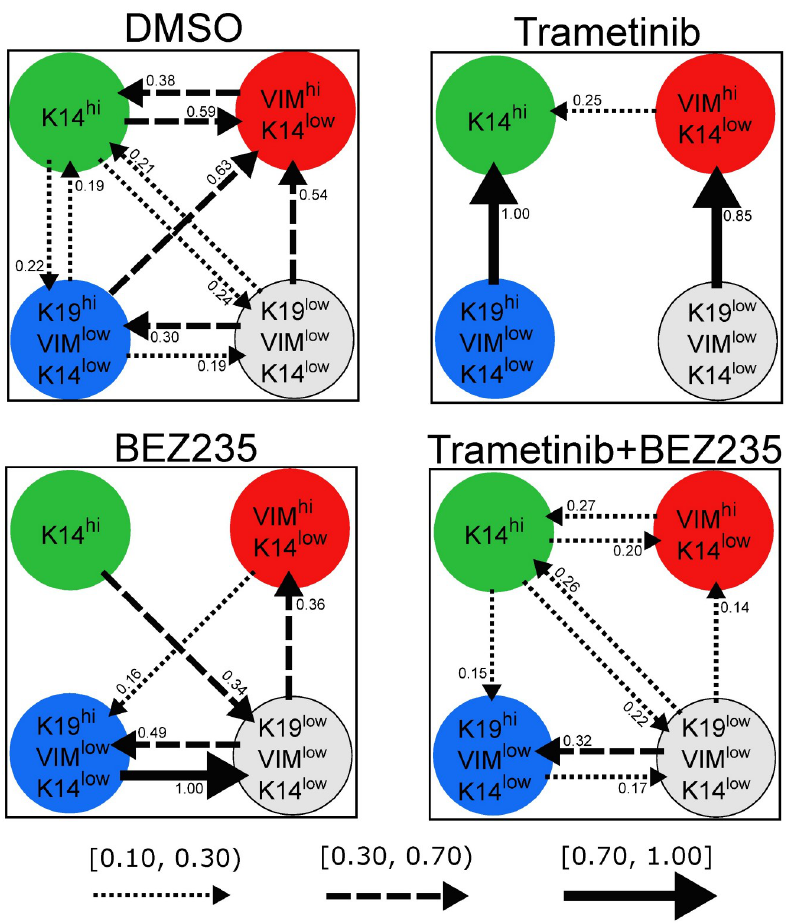
Fig 3. Drug-specific transition gains. For each treatment condition, values of the transition gains from the AM- optimized dynamics matrix are shown (units: #cells at ð k þ 1 Þ multiples of 12 hours i to differentiation state j of sufficient magnitude ( ρ ij � 0.10) is depicted as an arrow directed from i to j . Arrow style specifies gain magnitude. A dotted arrow means ρ arrow means ρ ij 2 [0.70,